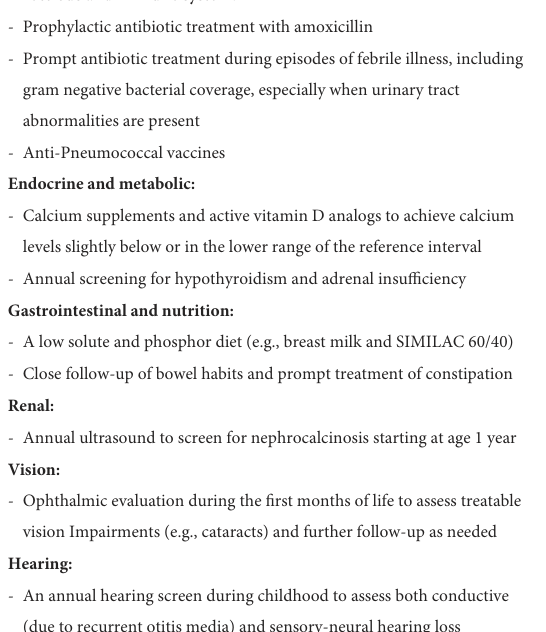
TABLE 2 Recommendations for HRD patients follow up and